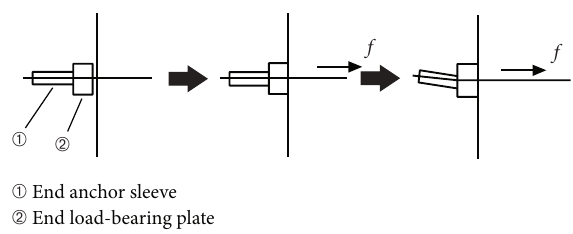
Figure 14: The o ff -axial phenomenon of end anchor sleeve during the tensioning